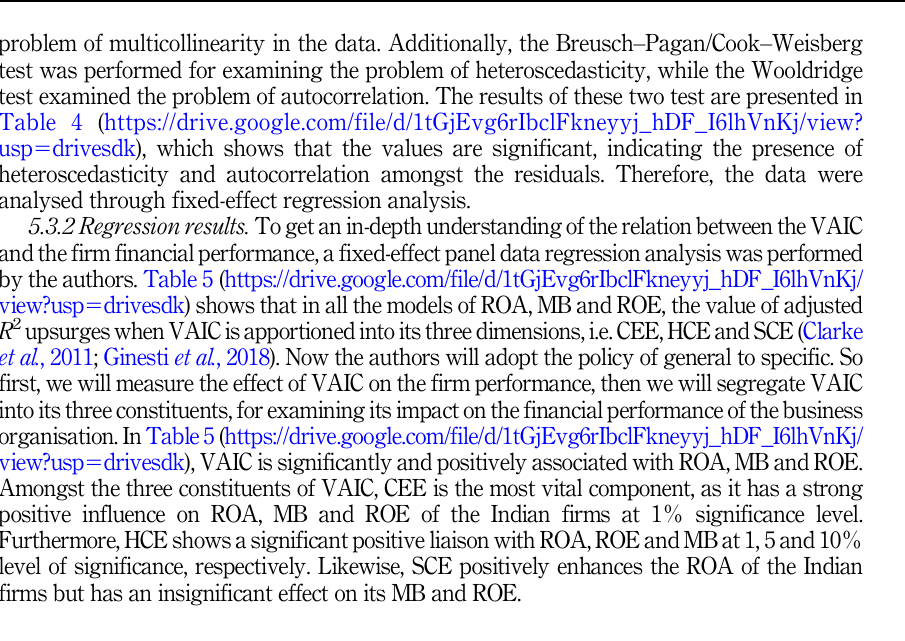
Table 3. Correlation matrix